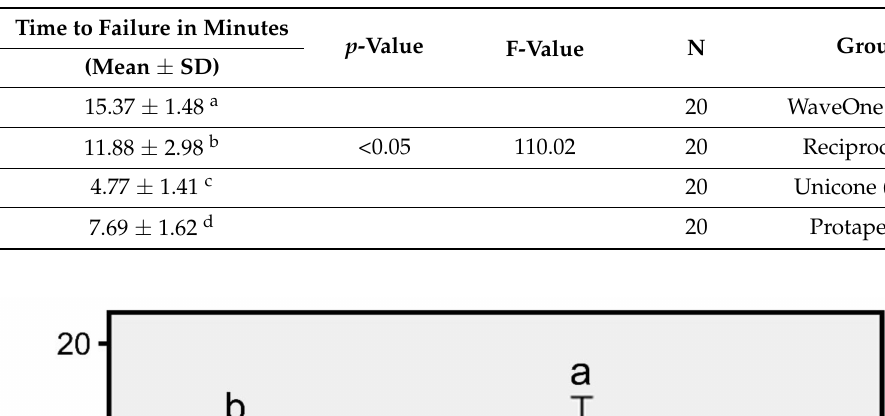
Table 2. The cyclic flexural fatigue resistance by recording the time to failure in minutes (means ± SD) of each file while the speed is constant ( n = 20). Values indicated by different letters are statistically different from each other ( p < 0.05).